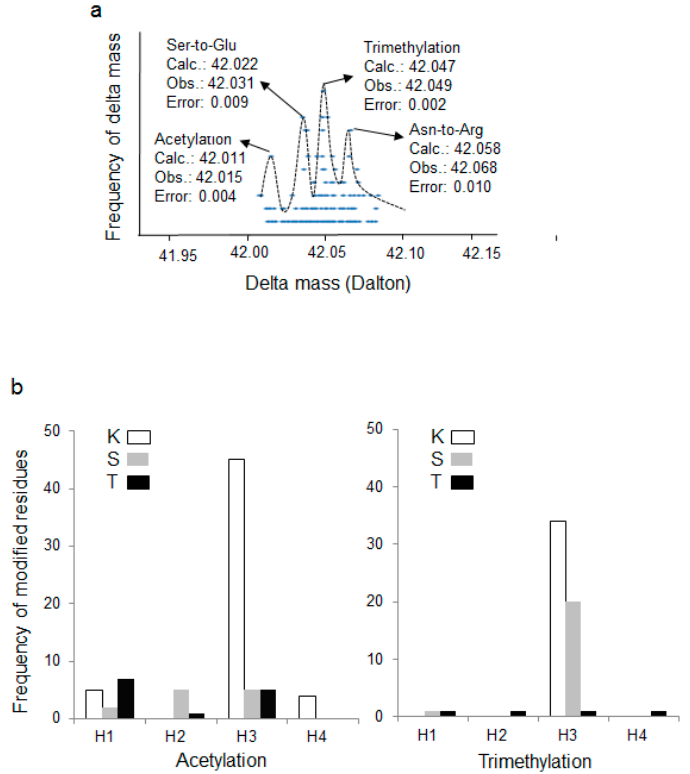
Figure 2. Clustering of the accurate delta masses at different residues of histones. ( a ) Frequency was plotted against their accurate delta masses. The calculated delta masses (Calc.) were from Unimod (http://www.unimod.org) and the observed delta masses (Obs.) were determined by the peaks considering the error range <10 ppm and the total frequency >20; ( b ) Acetylation and trimethylation at different residues of histones H1, H2 (H2A/B), H3 and H4 were confirmed by restricted search using SEQUEST. K, S and T, three amino acid residues as indicated.